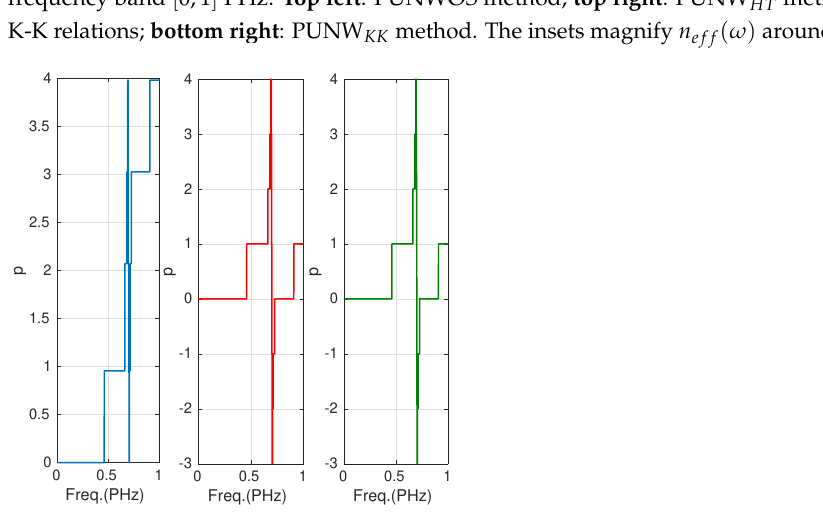
Figure 3. Values of the integer p over the band [ 0,1 ] PHz ( n s = 2048). Left : PUNWOS; centre : PUNW HT ; right : PUNW KK .